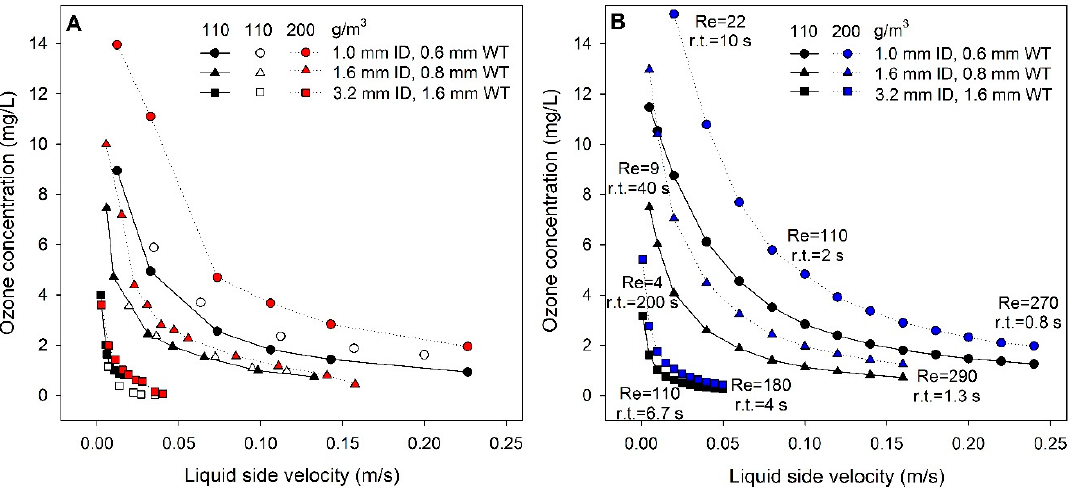
Figure 2. Dissolved ozone concentration in pure water in the outlet of the reactor against liquid velocity for different membranes diameters (ID: inner diameter, WT: wall thickness) and ozone gas concentrations. ( A ) Experimental results. Repeats (open symbols) were performed with a different set of membranes. ( B ) Computational fluid dynamics (CFD) modelling results, including Reynolds numbers (Re) and liquid side residence times (r.t.).